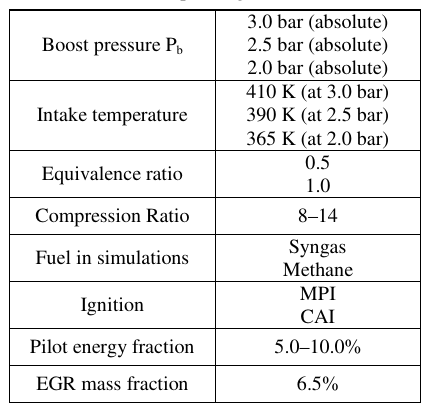
Table 3. Operating conditions